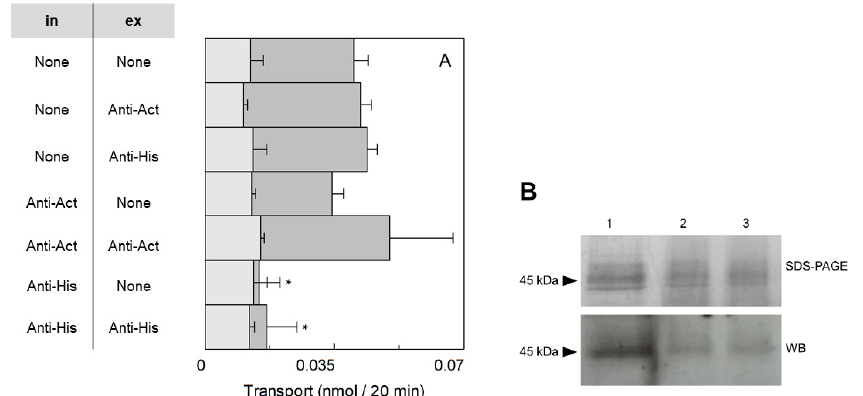
Figure 1. Sidedness of the reconstituted Solanum lycopersicum CAT2 ( Sl CAT2) in proteoliposomes. ( A ) Sl CAT2 was purified and reconstituted in proteoliposomes as described in Section 4.4. The purified protein was preincubated or not, for 30 min under rotatory shaker at room temperature, with 6 µ g of anti-His or anti-Actin antibody, as indicated in the table (in; intraliposomal compartment). Transport was measured in 20 min, as described in Section 4.5, by adding 100 µ M [ 3 H]Arg to proteoliposomes containing 200 mM sucrose and 15 mM ATP at pH 7.5. In the external compartment, 0.6 µ g of anti-His or anti-Actin were added or not, as indicated in the table (ex; extraliposomal compartment). The transport in proteoliposomes (dark gray bars) and in liposomes (light gray bars) is measured as nmol of radioactive substrate taken up in 20 min. Results are the means ± SD from three experiments. (*), significantly different from the control (none) for p < 0.05 as calculated from 1-way ANOVA test. ( B ) Sodium dodecyl sulfate polyacrylamide gel electrophoresis (SDS-PAGE) of 0.15 µ g purified Sl CAT2 (lane 1) and the corresponding protein volume of Sl CAT2 reconstituted in proteoliposomes not preincubated with antibody (lane 2), after preincubation with anti-His antibody (lane 3). Proteoliposomes were purified by size-exclusion chromatography as described in Section 4.5 prior to SDS-PAGE